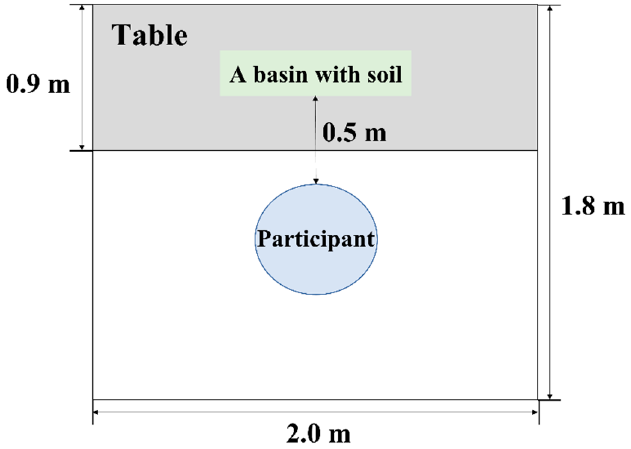
Figure 2. Room arrangement of the experiment.